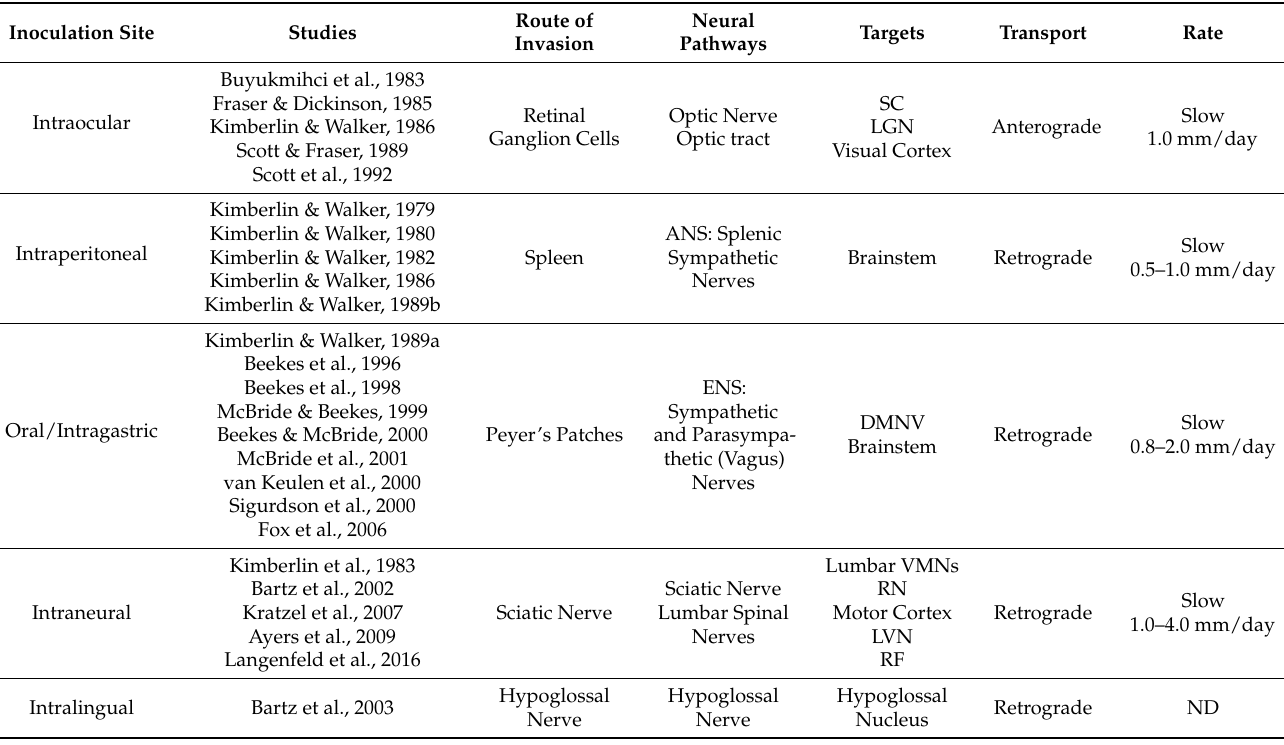
Table 1. Summary of prion pathogenesis